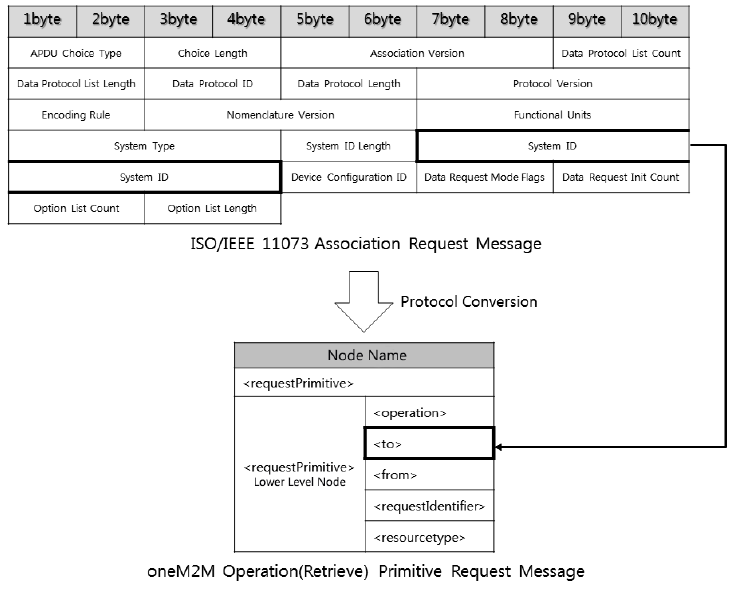
Figure 5. Conversion of an ISO/IEEE 11073 Association Request message to a oneM2M Retrieve primitive Request message.